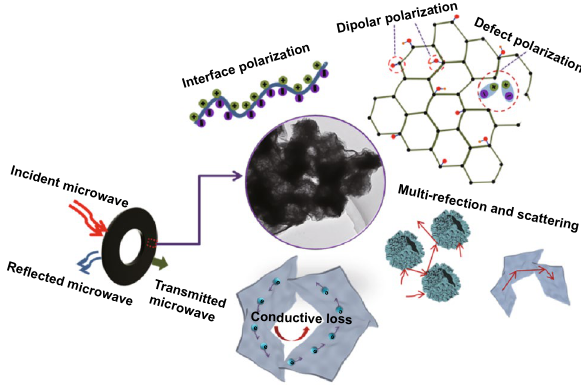
Fig. 10 Comparison of the MA properties of various related materi‑